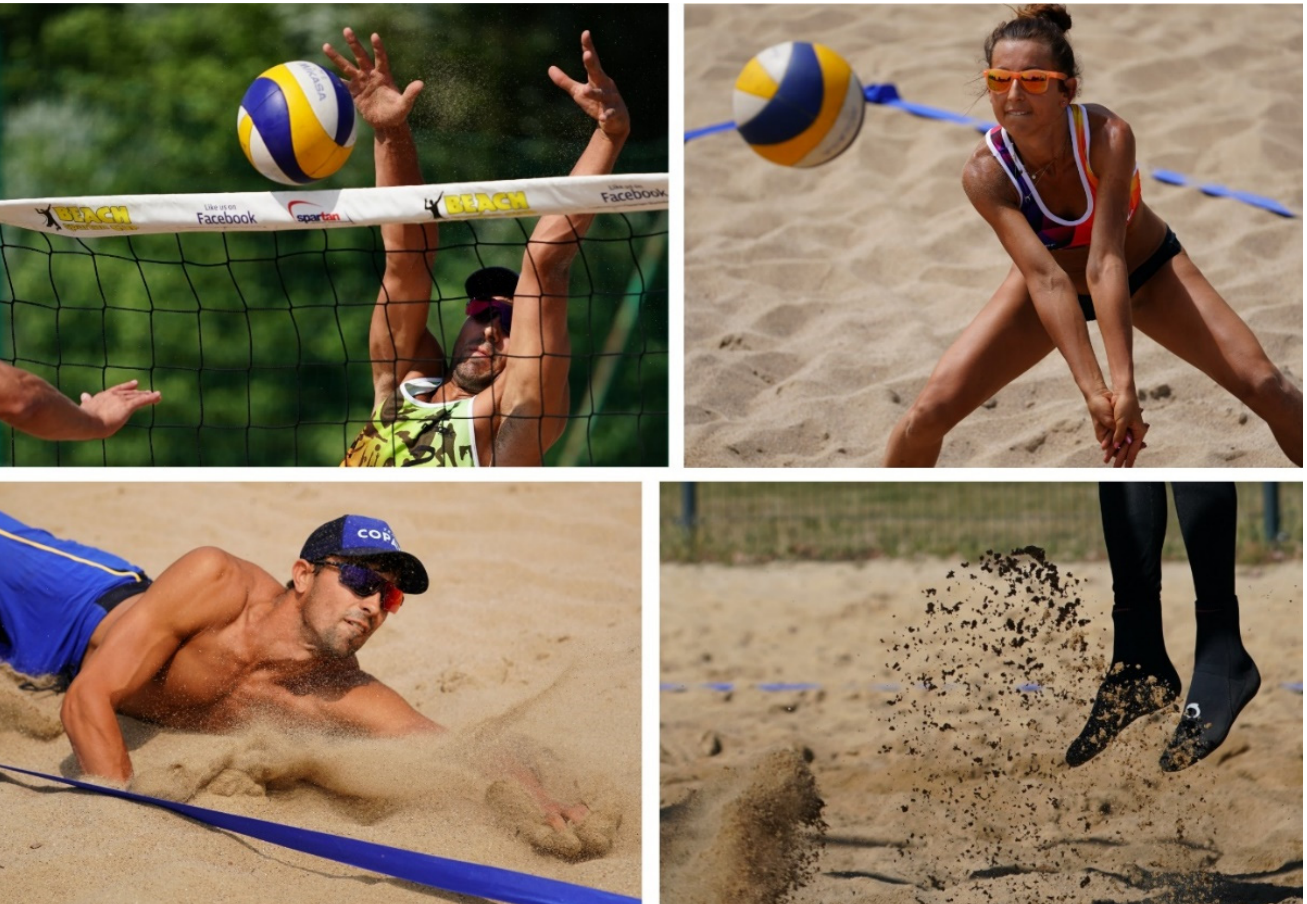
Figure 1. The growing popularity of beach volleyball means that sand courts are built not only on beaches. The quality of play in this case is determined by the sand used. In the photos are the following players: Maciej Westfal, Natalia Czarnecka, and Piotr Brzóstowicz (photo by M. Kasprzak, published with the permission of the photographed persons).